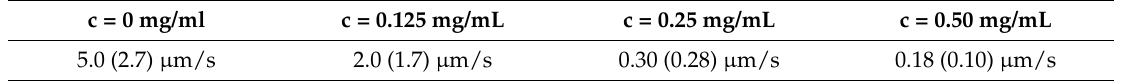
Table 2. Average growth rate of ice particles.